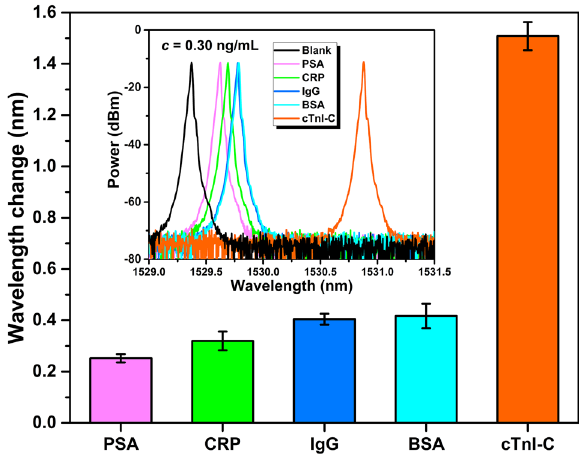
Figure 11: Peak wavelength changes of sensing laser with the interference and cTnI-C samples for specificity test (PSA: prostate specific antigen; CRP: C-reactive protein; IgG: immunoglobulin G; BSA: bovine serum albumin). Inset: the corresponding sensing laser spectra. Each sample was injected into to the microtubule cavity at the same concentration of 0.3 ng/mL in PBS